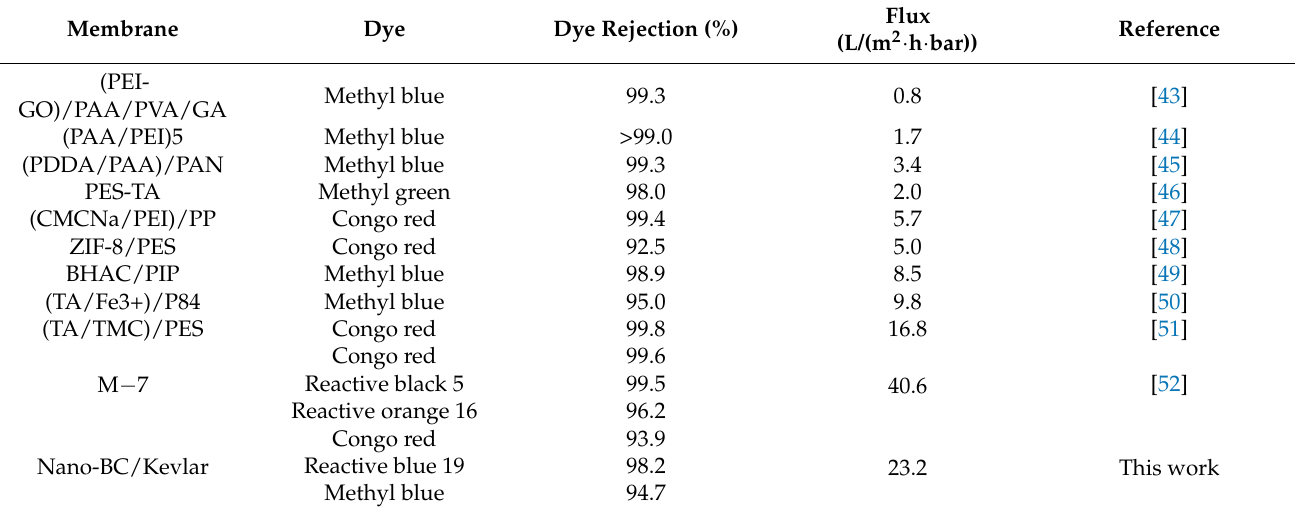
Table 3. Performance of different membranes reported by the literature.